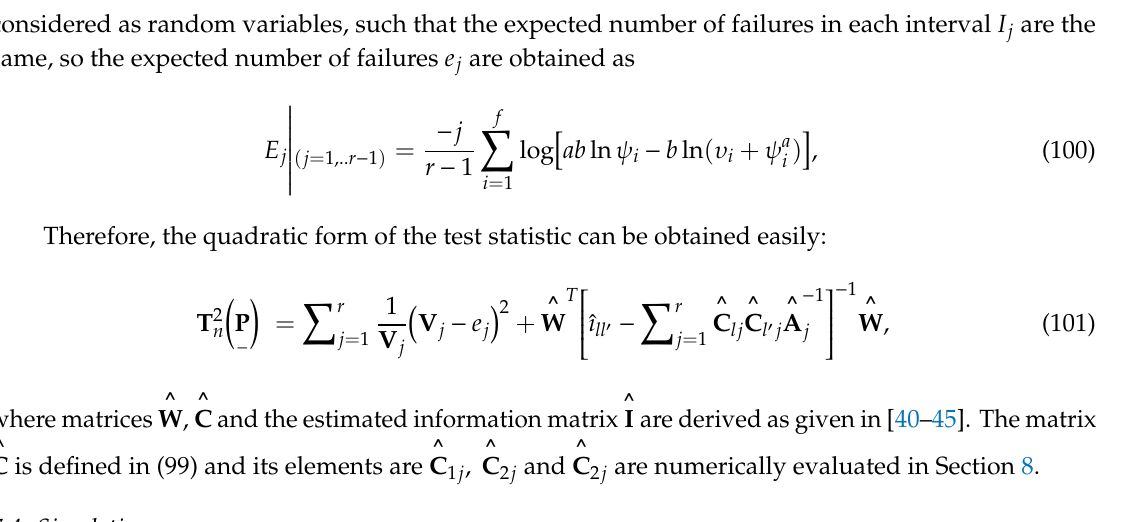
Table 13. MLEs of a, b, θ , and MSE.